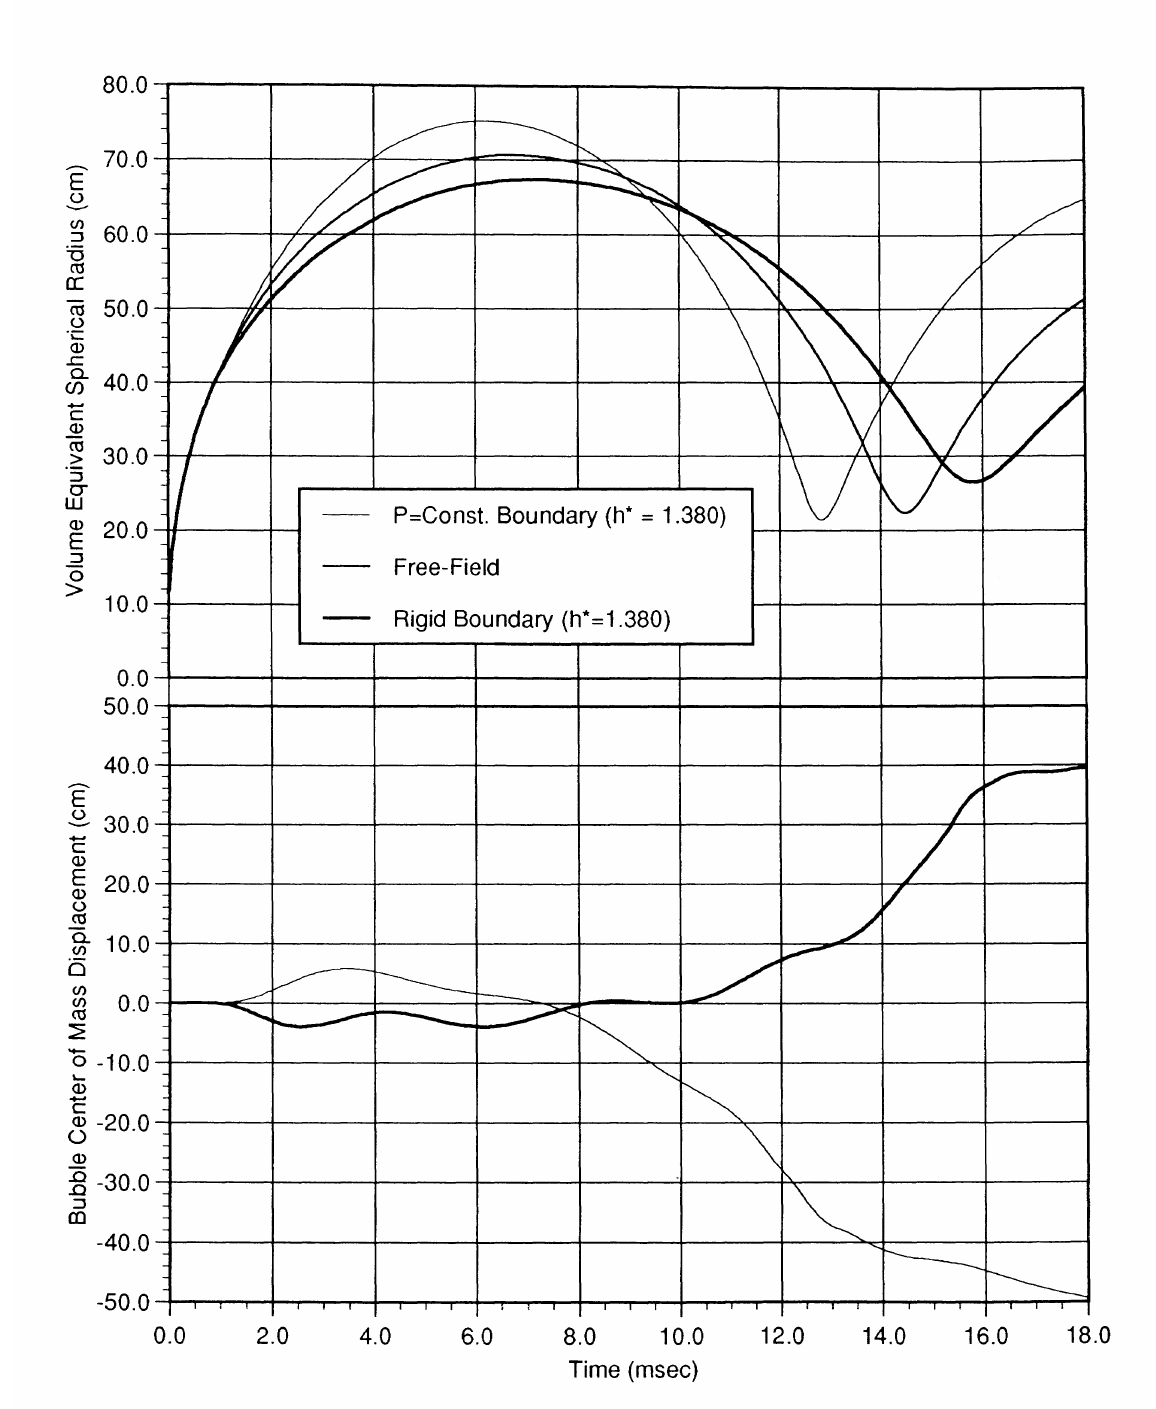
FIGURE 7 Equivalent spherical radius and center of mass displacement versus time behav ior for the bubble near the boundary problem